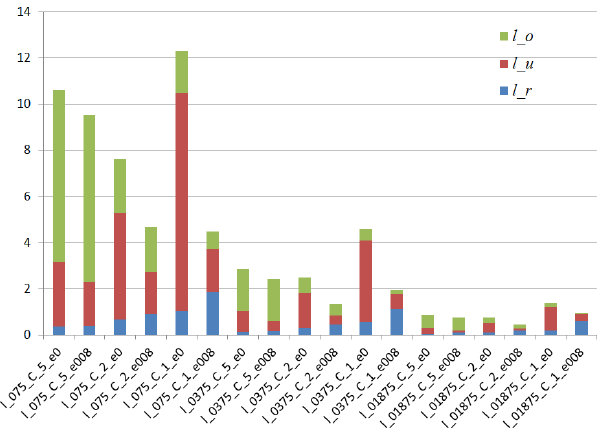
Figure 14. A histogram of the mixing diagnostic (stacked) for the same resolutions, Courant number and smoother factor as in Fig. 13. Metrics are the following (see text and Lauritzen et al. (2012) for more details): l r is “real mixing”, l u is “range-preserving unmix- ing”, and l o is “overshooting”. Values are relative to the reference CSLAM performance in L14 tests. The picture is comparable with panel (b) of Fig. 15 in L14.